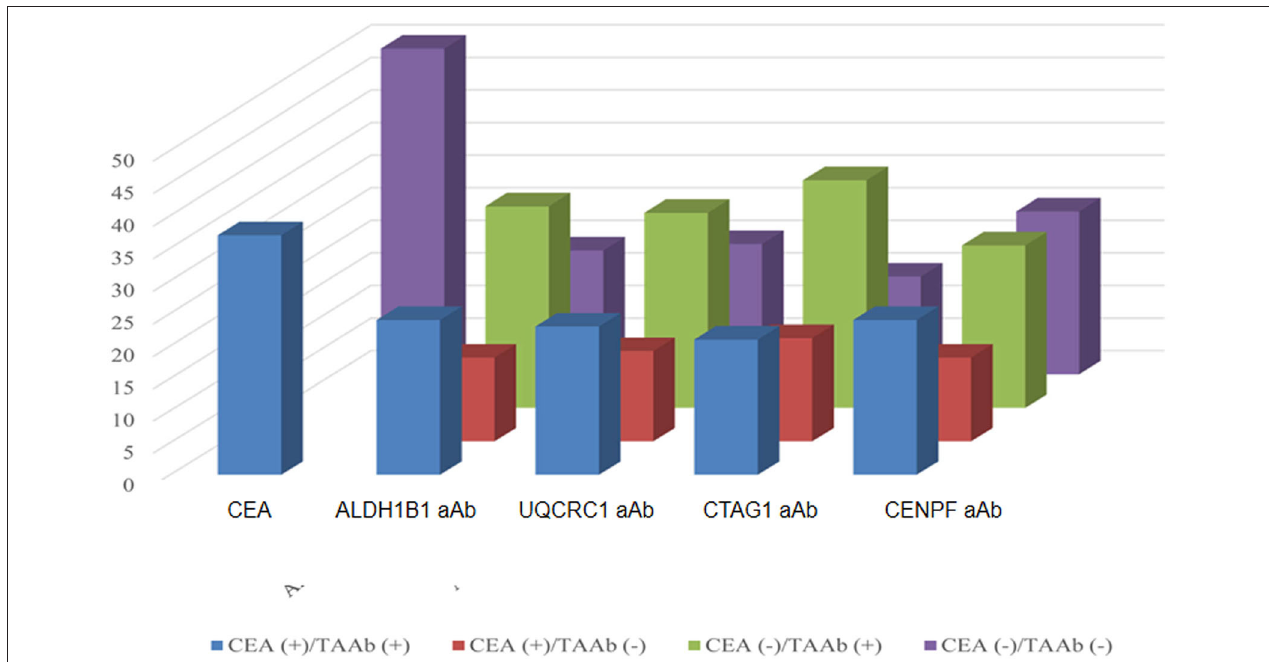
FIGURE 5 | Comparison of the positivity rates of CEA and autoantibodies against TAAs in CRC patients. The numbers of positive and negative cases of autoantibodies against ALDH1B1, UQCRC1, CTAG1, and CENPF in CRC patients who were positive (in blue) or negative (in purple) for CEA. TABLE 3 | Autoantibodies positive for candidate tumor-associated antigens in colorectal cancer patients negative for CEA. CEA ALDH1B1